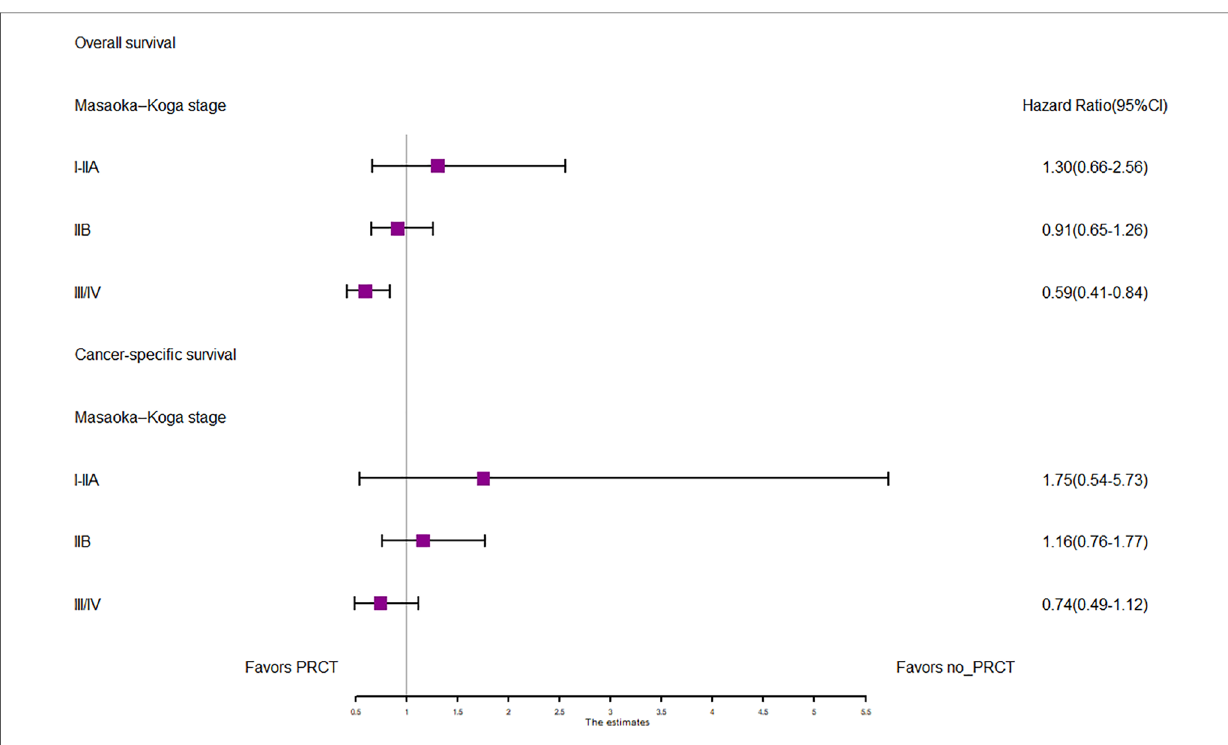
FIGURE 4 Forest plots of OS and CSS in the POCT and no POCT groups in patients undergoing surgery for TETs at different stages before propensity